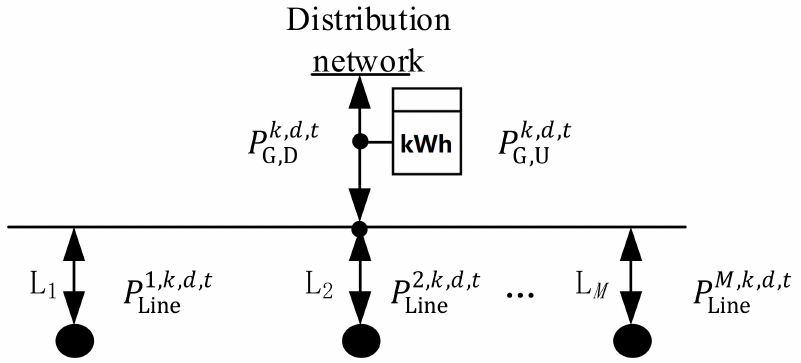
Figure 2. Topology of gateway meter for power